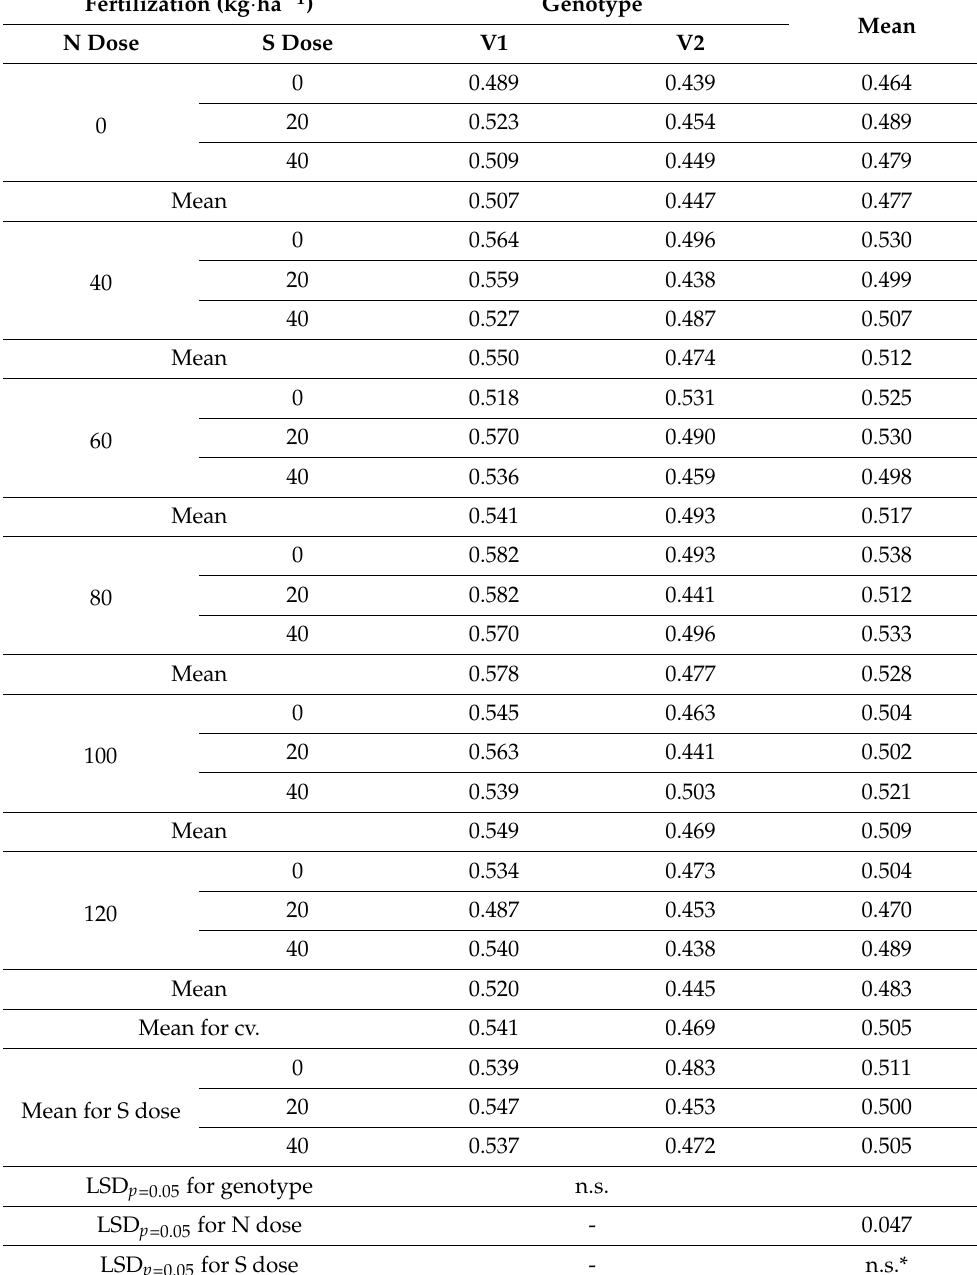
Table 6. NDRE of winter wheat genotypes under